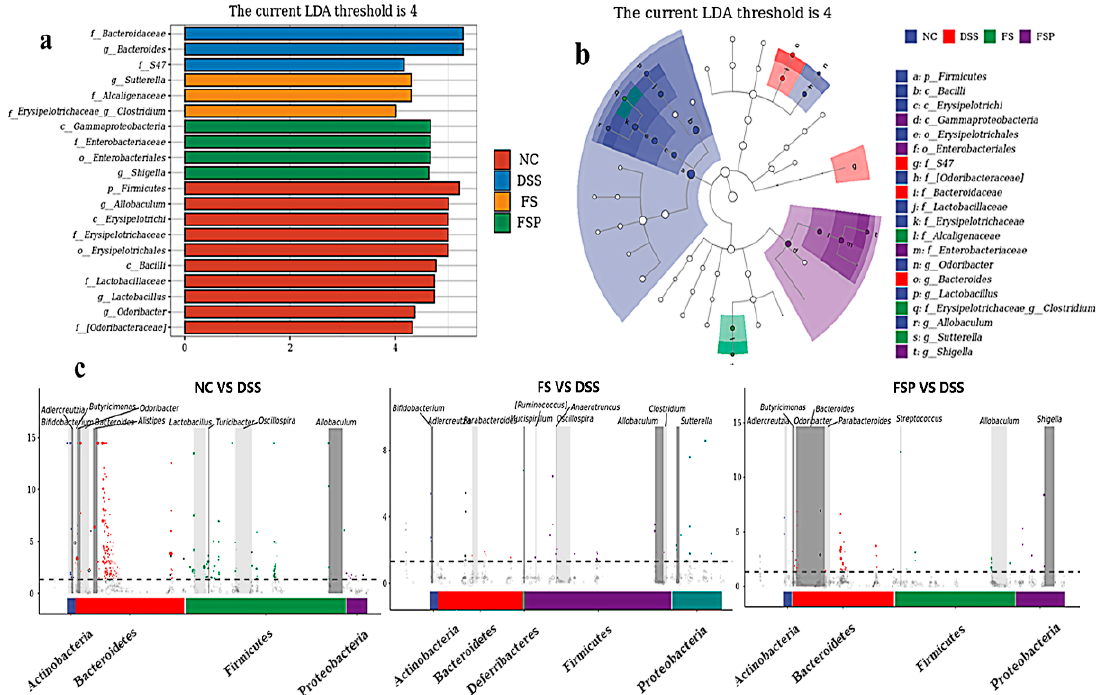
Figure 7. Taxonomic histogram ( a ) and cladogram ( b ) generated by LEfSe analysis and matastats analysis ( c ).